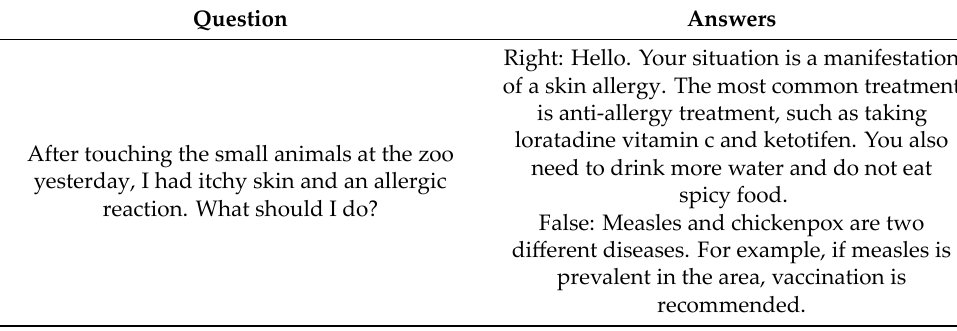
Table 2. Example of a medical QA pair in knowledge‑based